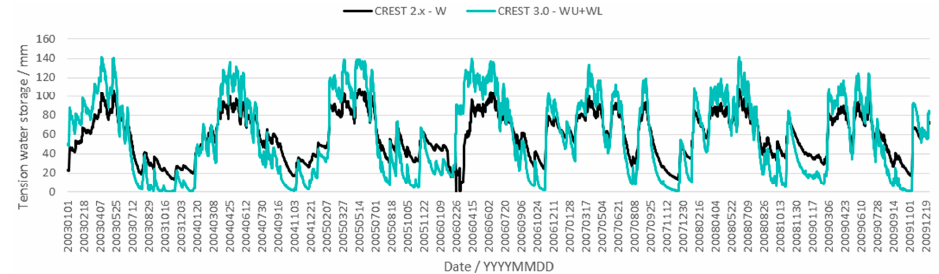
Figure 5. Simulated tension water storage of CREST 2.x and 3.0 models. W: total soil moisture; WL: lower layer soil moisture; WU: upper layer soil moisture.